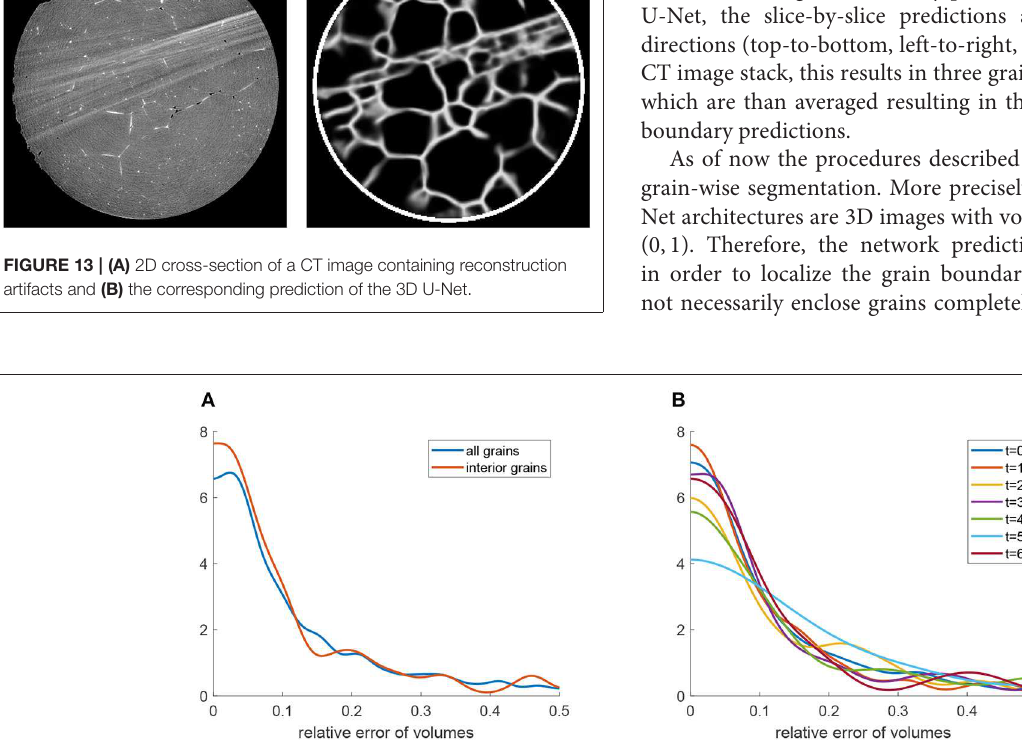
Frontiers in Materials |